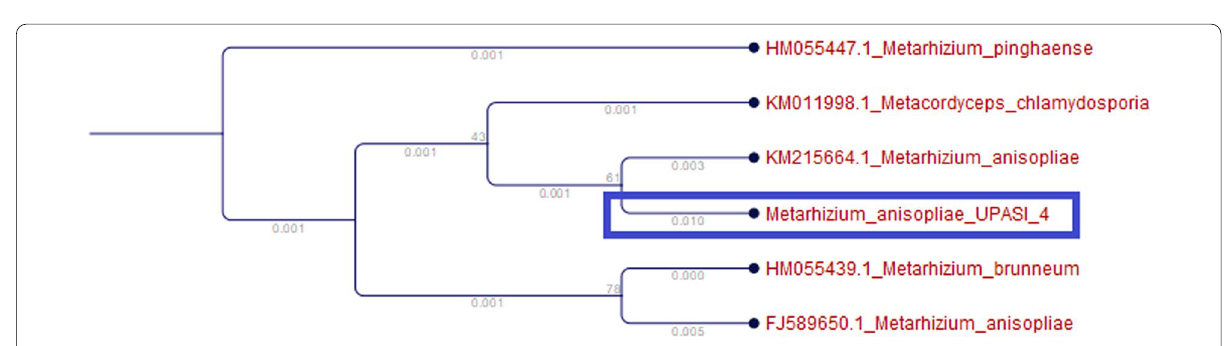
Fig. 4 Phylogenic tree of Metarhizium anisopliae isolate UPASI_4